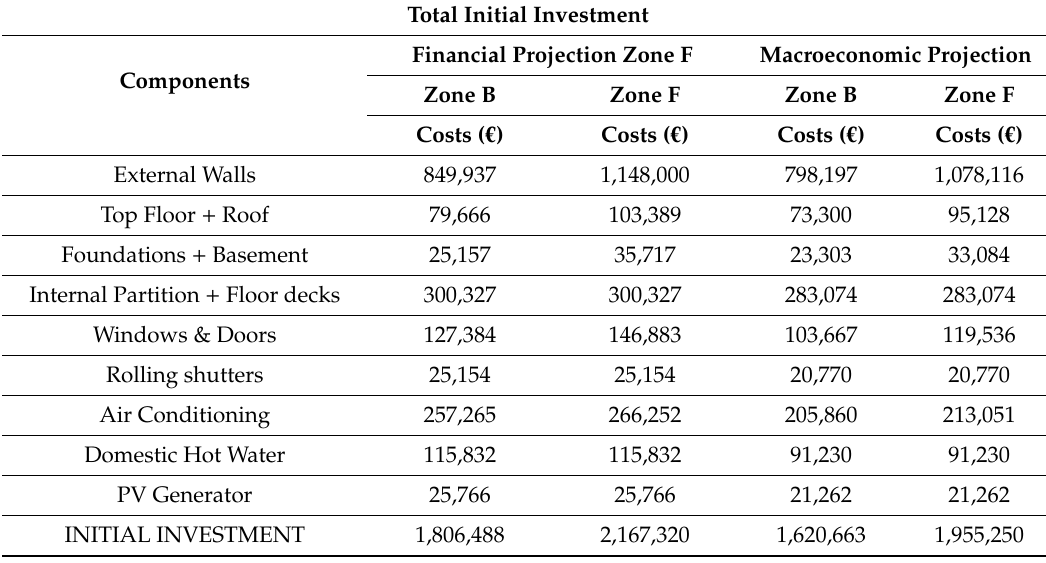
Table 6. Initial investment costs required for the reference building (RB) in climatic zones B and F, classified as a function of the main expense